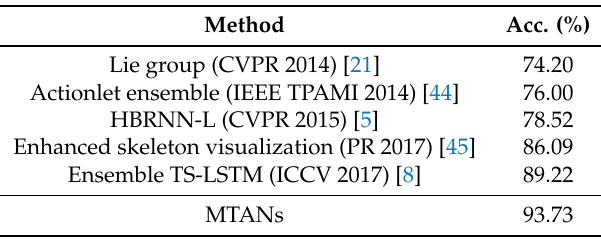
Table 9. Comparison on the Northwestern-UCLA dataset in accuracy